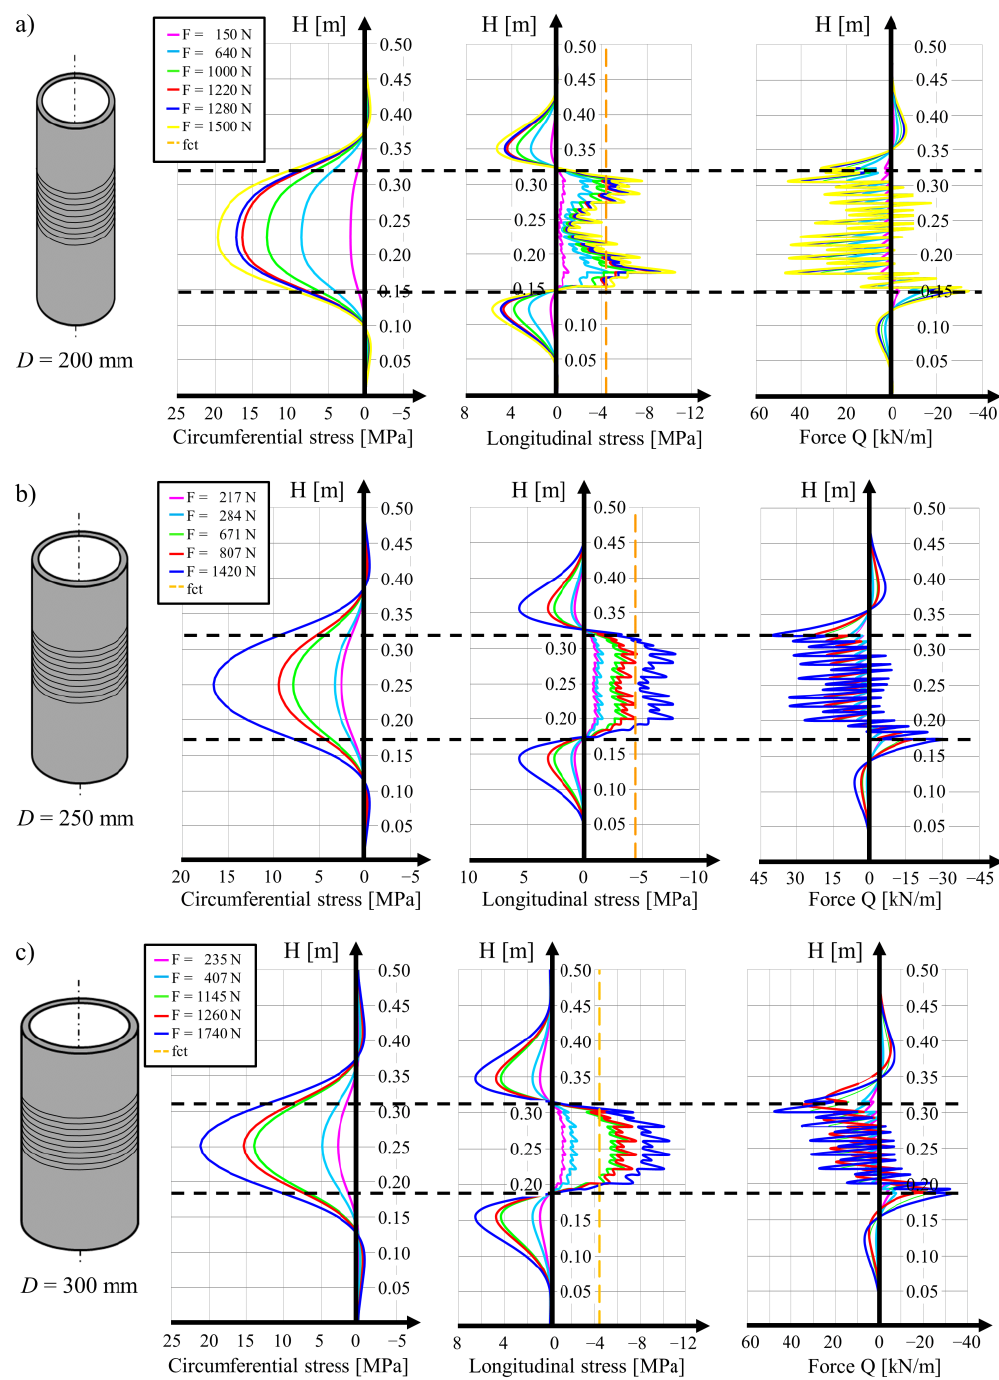
Figure 2. Static analysis from the NOAM calculation software: ( a ) profiles of circumferential and longitudinal stresses and cross-section forces for a hollow cylinder with an external diameter of 200 mm prestressed with a Ni-Ti wire with a diameter of 2 mm, ( b ) the same for a cylinder with a diameter of 250 mm, ( c ) the same for a cylinder with a diameter of 300 mm.